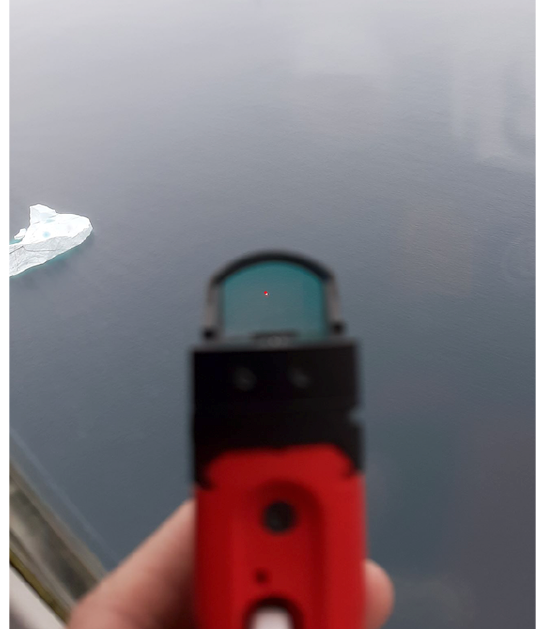
Figure 5. A Geometer used during an aerial survey in Greenland. Viewed through the reticle, a red sighting dot (enhanced here for visibility) marks the spot to where an angle will be recorded by clicking the Geometer’s trigger button. The Geometer also can measure earth’s magnetic field and can estimate the aiming direction. As aircraft are metallic and deployed to various places on earth, the Geometer needs to be calibrated in the field for proper direction values. Currently, experiments are being conducted to determine the accuracy of Geometer heading estimates in different